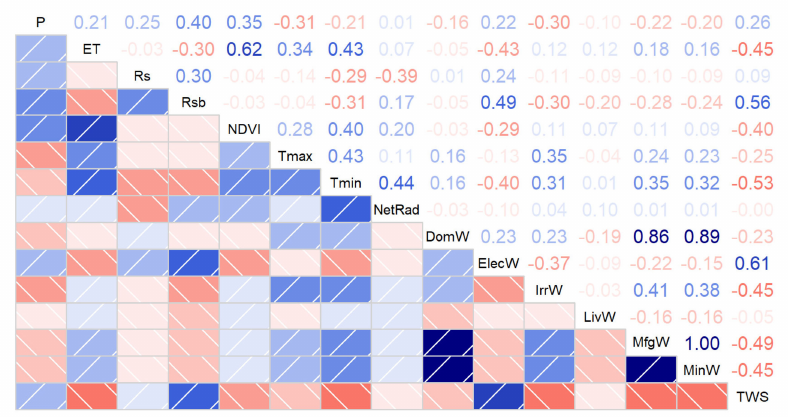
Figure 6. The diagram of correlation coefficient matrix between variables, the upper triangle number is the value of correlation coefficient, red indicates negative correlation, and blue indicates positive